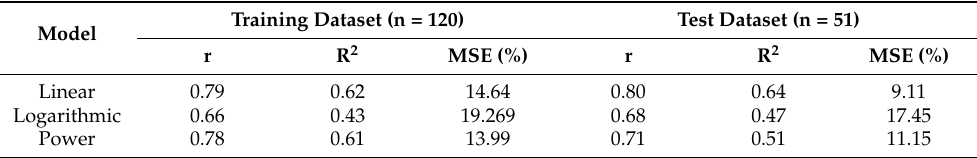
Table 5. Evaluation of multivariate parametric regression models for vegetation coverage.